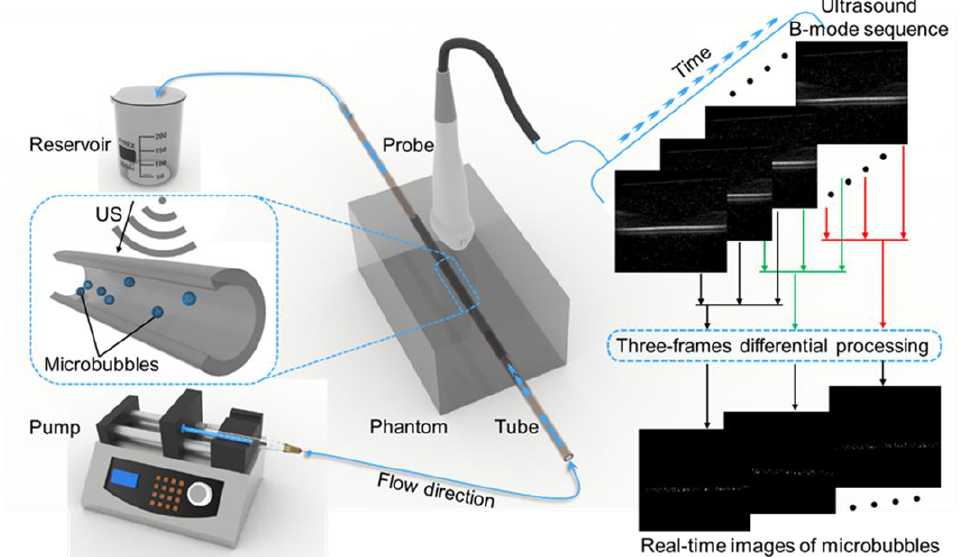
Figure 4. Schematic diagram of the ULM for imaging the phantom. The right side of the diagram shows the reconstructed phantom US images and the real-time MB images processed by the three- frame difference algorithm.